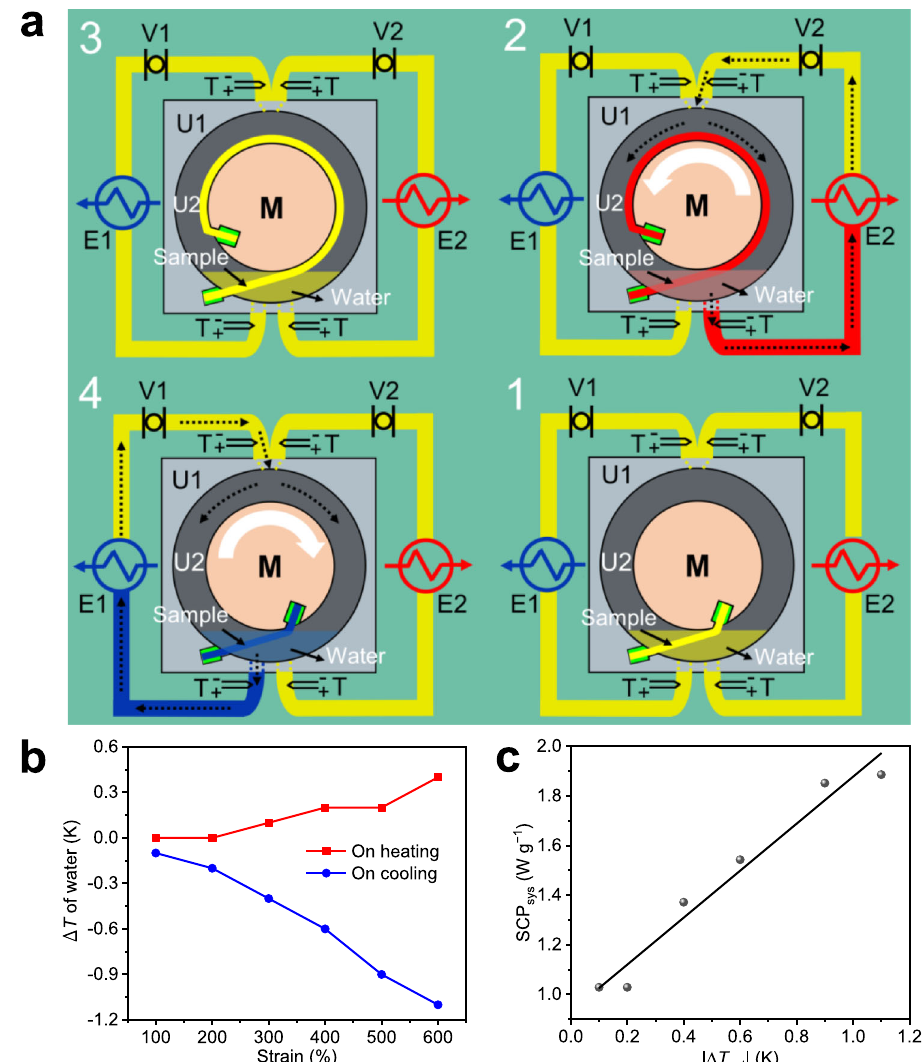
Fig. 4 Principle and performance of rotary motion cooling device. a Schematic diagram of the cooling device. Stage 1: one end of sample is fi xed on the body case (U1), and the other is fi xed to the revolving disc (M). Stage 2: M rotates counterclockwise causing the elongation of sample. Water fl ows toward the hot heat exchanger (E2) to release heat to the environment. Stage 3: The sample maintains elongation until the sample and water temperature recover to T a . Stage 4: M rotates clockwise causing the contraction of sample. Water fl ows toward the cold heat exchanger (E1) to absorb heat from the environment. The symbols V1 and V2 represent precision pumps. The symbols T represent thermocouples. U2 is a cavity that allows water fl ow and sample dilation. The mass of water in U2 is constant. The black dotted arrow points to the fl ow direction of the water. The white arrow points to the rotation direction of M. b Temperature changes of outlet water versus strain after a single cycle. The strain of sample was adjusted by controlling the rotation angle of M. c The SCP sys vs. Δ T out of the rotary motion elasto-based cooling